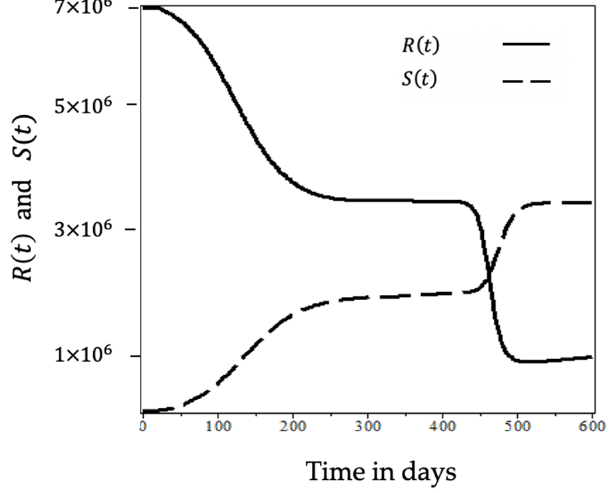
Figure 10. Development of the number of suspected 𝑆(𝑡) and recovered 𝑅(𝑡) individuals with time without vaccination.